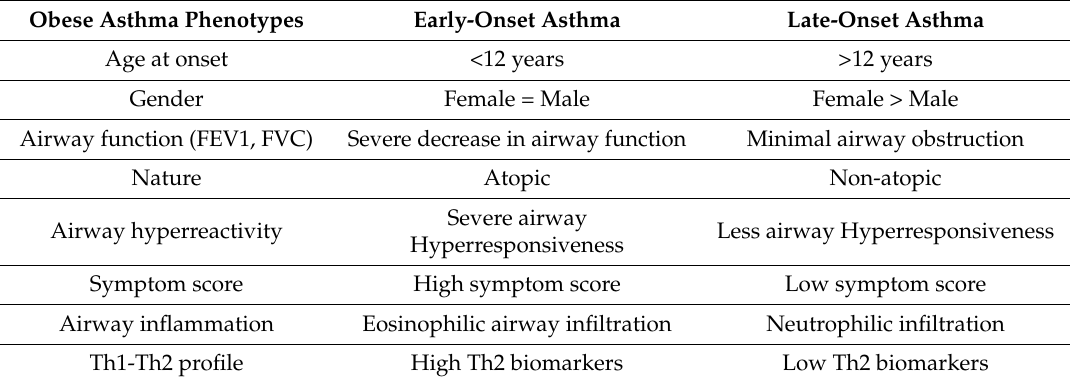
Table 1. “Obese asthma”